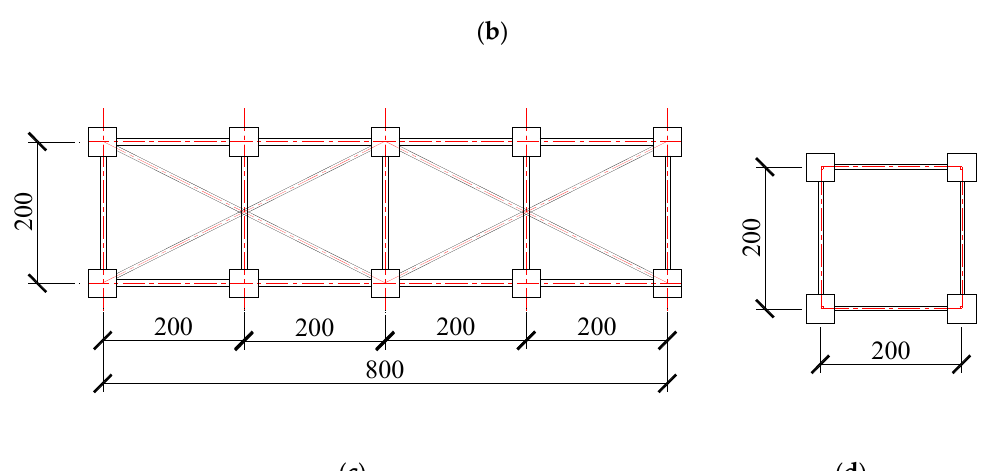
Figure 9. Design of the steel truss model structure (mm): ( a ) steel truss model; ( b ) 1-1 plane sketch of the bottom beam; ( c ) 2-2; ( d ) 3-3.